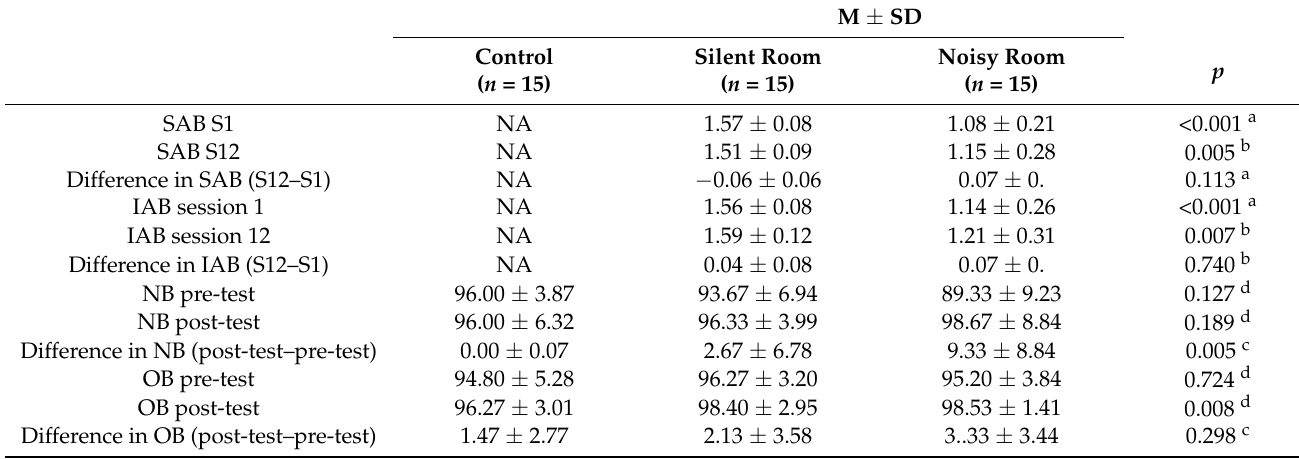
Table 1. Differences in standard alpha band (8 to 12 Hz), individual alpha band relative amplitude and performance tests between protocols.